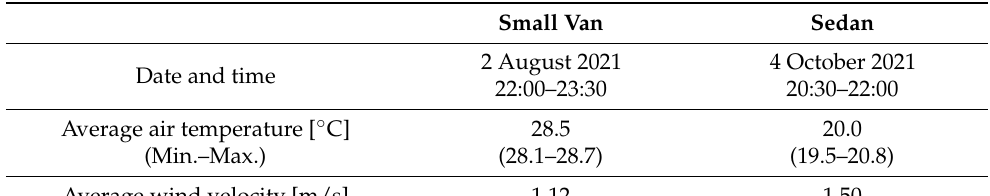
Figure 2. Heat flux sensors and other sensors on the vehicle roof: small van ( top ), sedan ( bottom ).